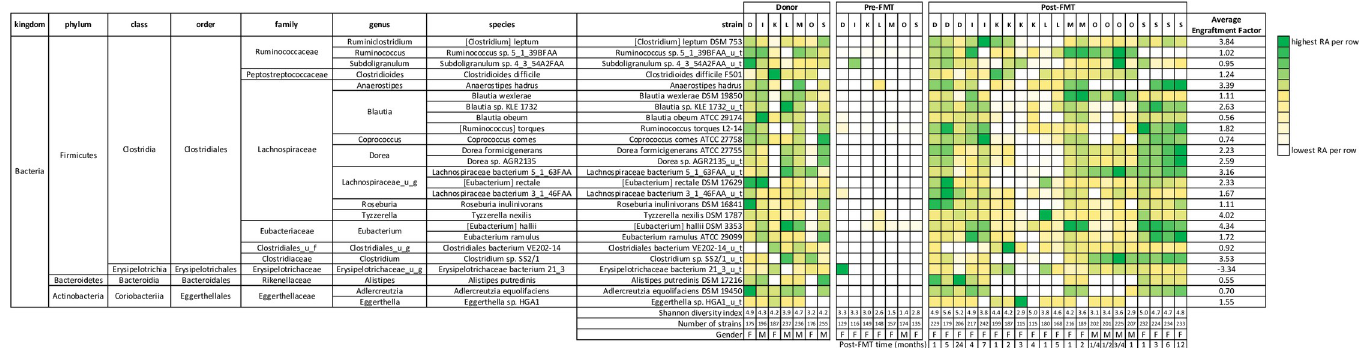
Fig 7. Heat map depicting the longitudinal mapping of the top 25 strains according to the relative abundance in the post-FMT group. The bottom of the heat map indicates sample collection time point in months post-FMT, Shannon index and total number of bacterial strains. Engraftment of bacterial strains from corresponding healthy donors was noted in patients with RCDI after FMT.